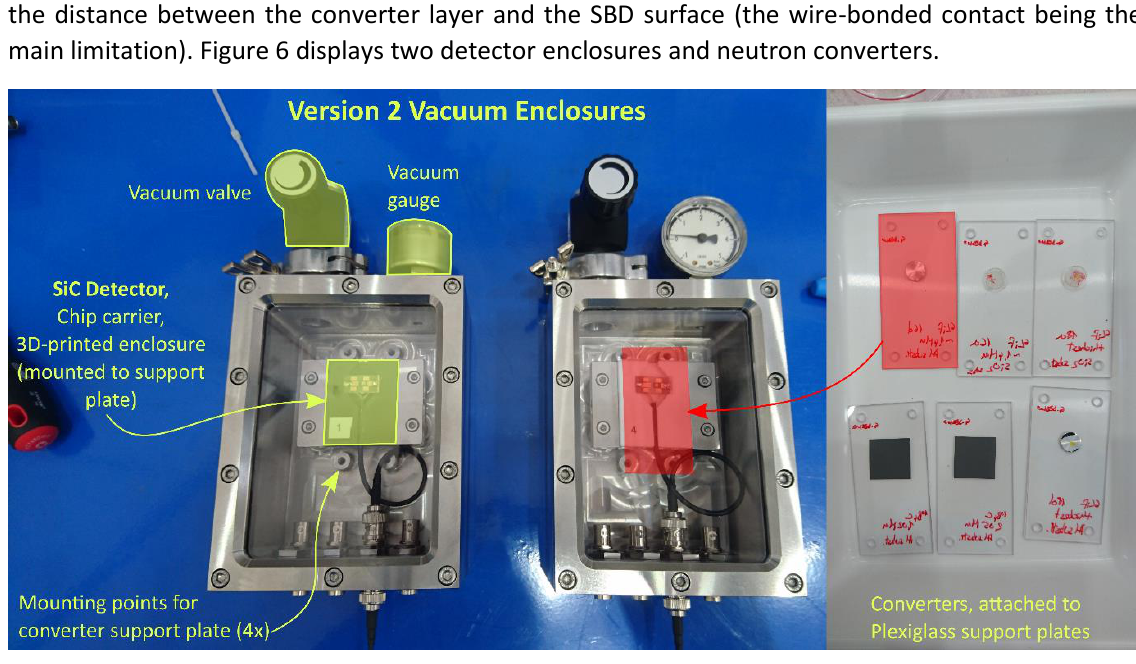
Figure 6: Version 2 detector enclosures. Left: two detector enclosures, right: neutron converting layers attached to Plexiglas support